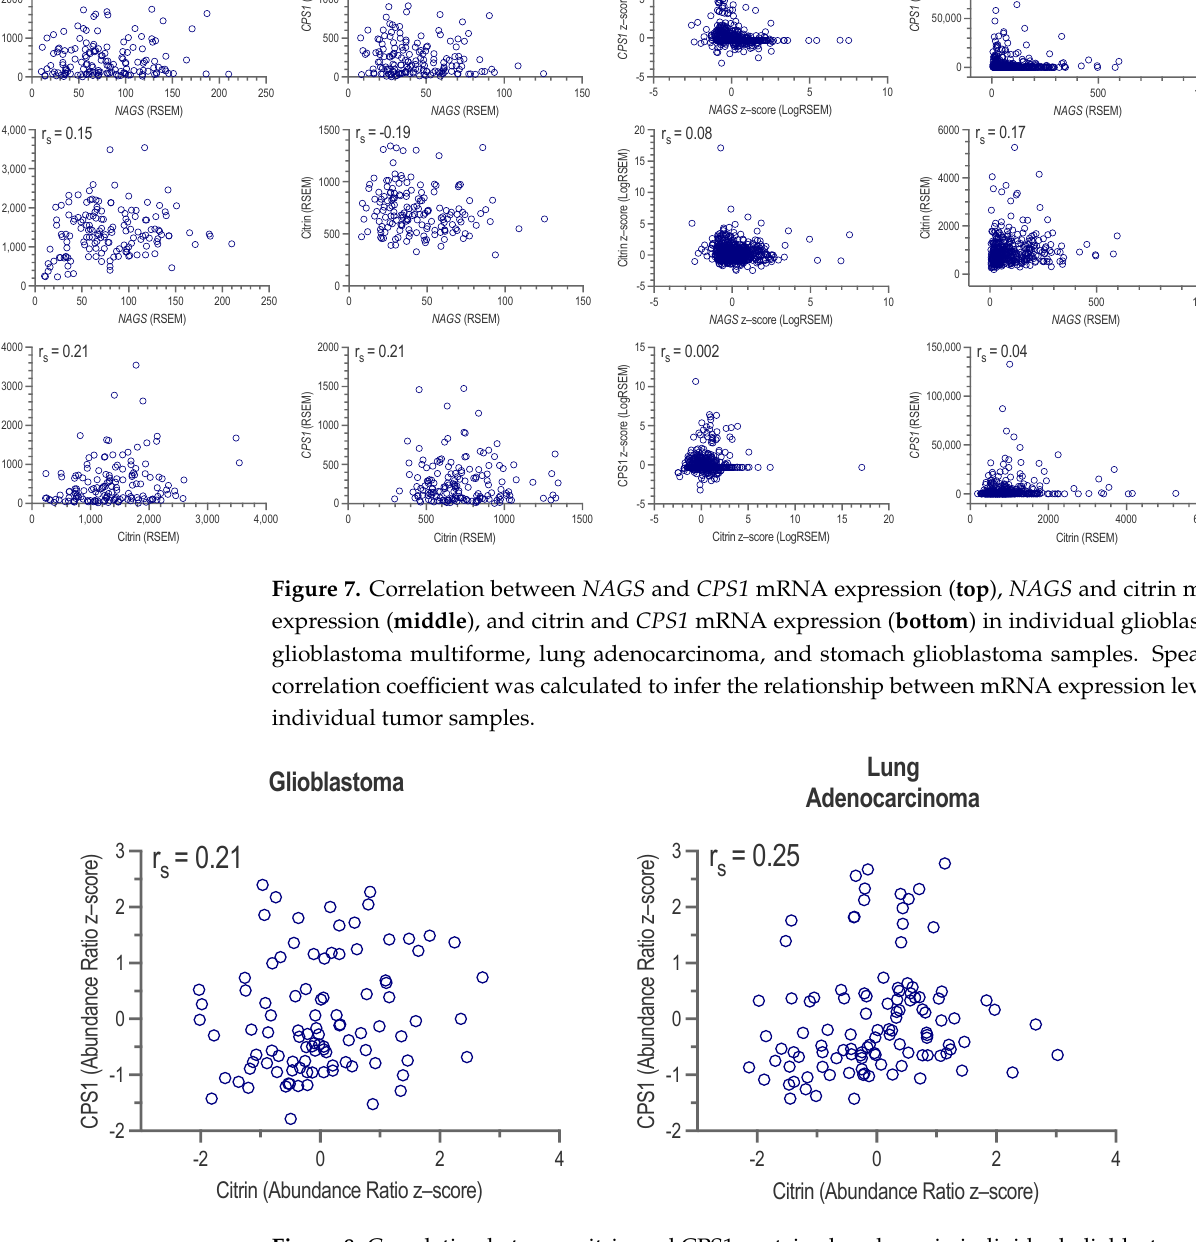
Figure 8. Correlation between citrin and CPS1 protein abundance in individual glioblastoma (left) and lung adenocarcinoma (right) samples. Spearman correlation coefficient was calculated to infer the relationship between protein abundance in individual tumor samples.